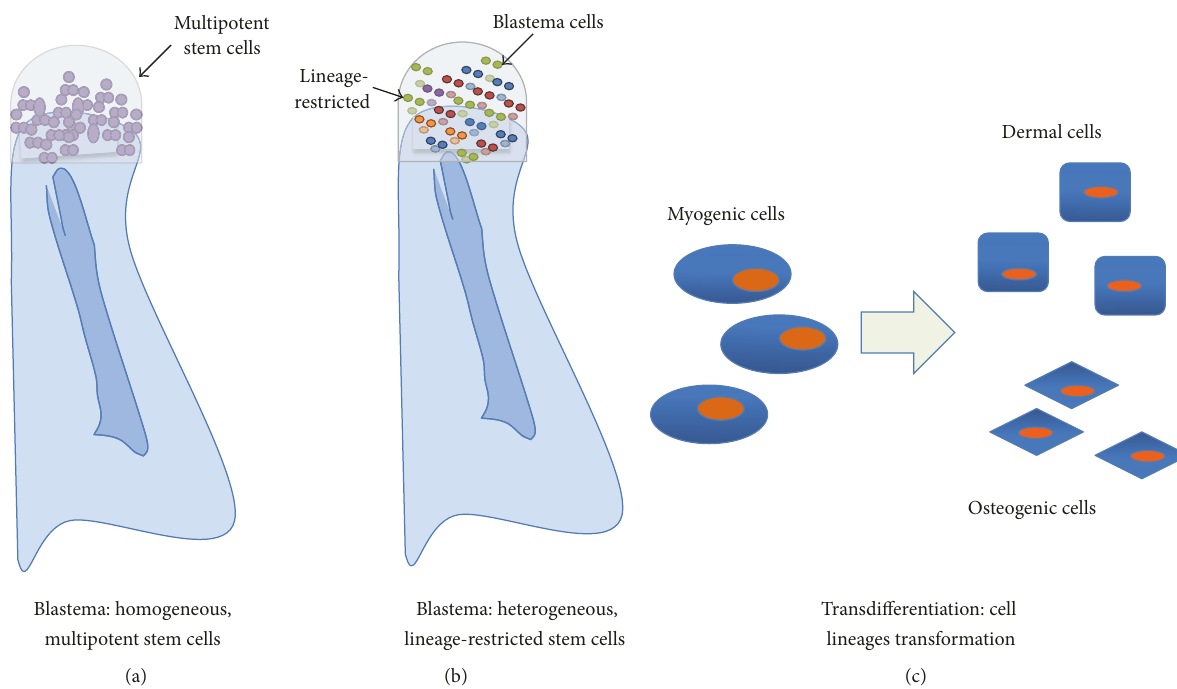
Figure 1: The blastema is a group of cells originating from the limb tissue local to the amputation site. (a) It was originally speculated that the blastema is a homogeneous structure of multipotent cells (purple dots), which would then form all the structures of the amputated digit tip or limb. (b) However, recent studies in the regeneration of both axolotl limb and zebrafish fin have demonstrated that the blastema cells are a heterogeneous assortment of lineage-restricted , unipotent progenitor cells (colorful dots). (c) Cell transdifferentiation might also play a role in the formation of blastema cells. Dermis and skeletal tissue, both of lateral plate mesodermal origin, have been shown to transdifferentiate. The blue area in (a, b) represents the remaining tissues following digit